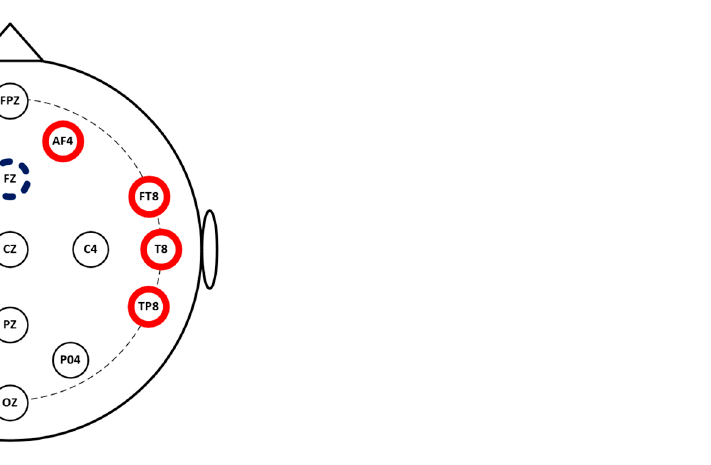
Figure 2. Two frontal electrodes (AF3 and AF4) and six temporal electrodes (FT7, FT8, T7, T8, TP7, and TP8) selected in the study.